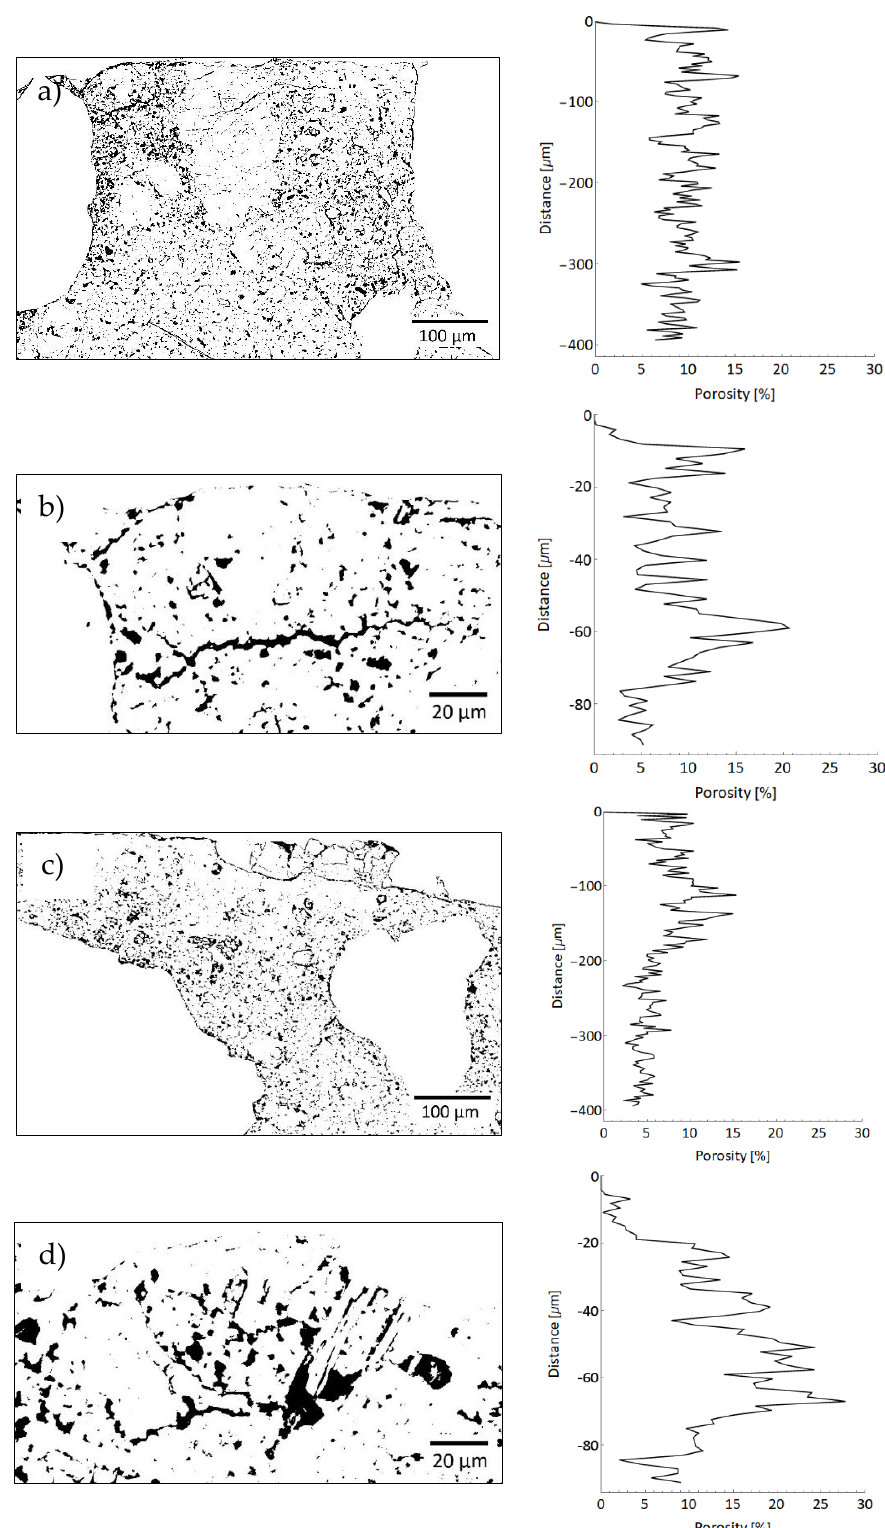
Figure 20. Pores in the tested sample (black pixels) and graphs of the fractional share of pores along the sample’s height for: ( a , b ) unmodified sample, ( c , d ) sample modified with 0.5% of polypropylene fibers.